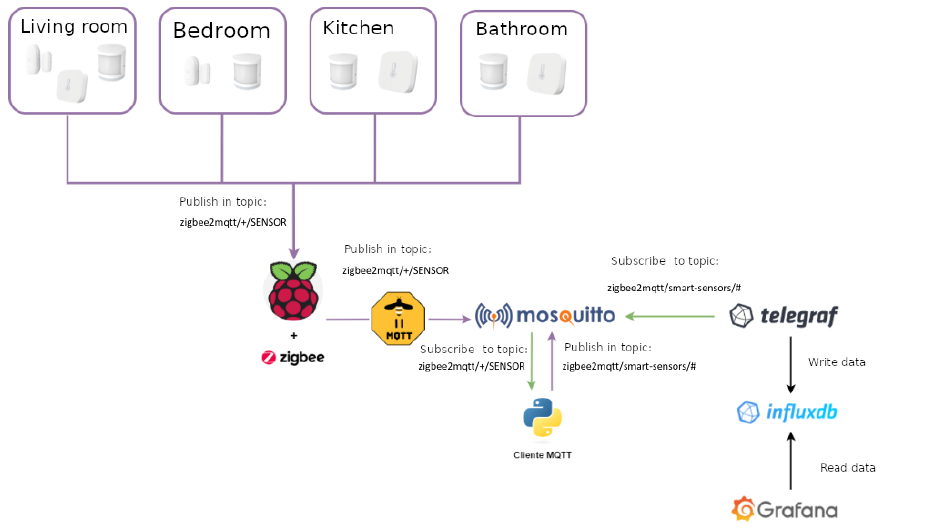
Figure 18. Architecture of the home monitoring